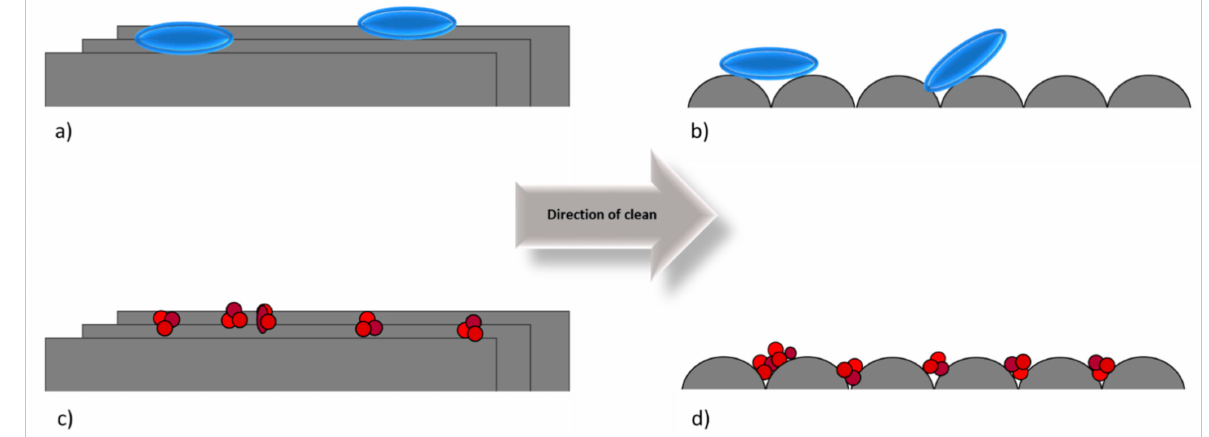
Figure 5. Schematic demonstrating how ( a , b ) the size of the bacteria (cylindrical) and ( c , d ) meat exudate (circles) influenced the efficacy of cleaning in the ( a , c ) direction of cleaning along the linear surface features or ( b , d ) in a direction perpendicular to the surface features.